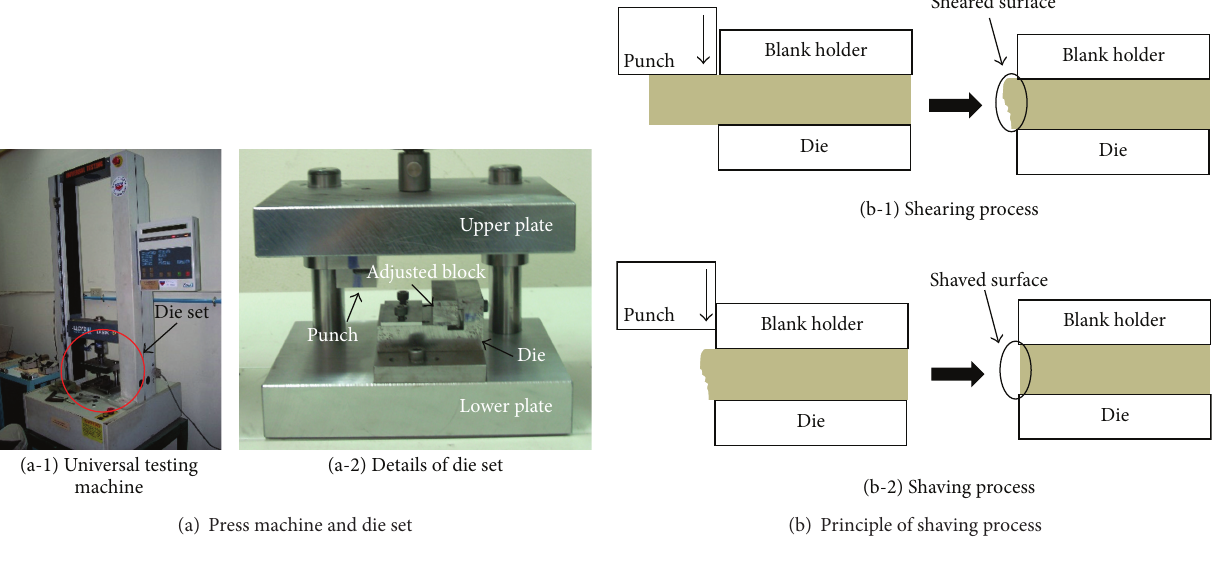
Figure 1: Experimental equipment and principle of shaving